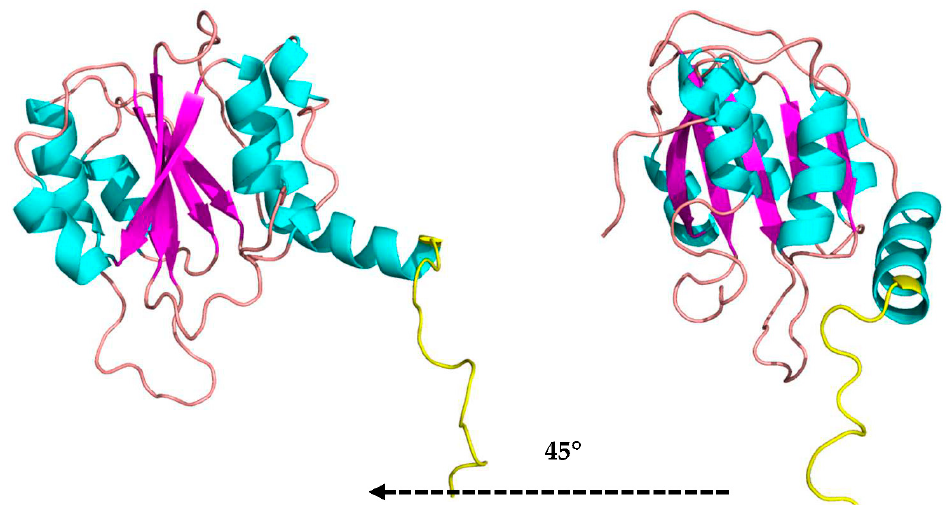
Figure 4. The C-terminal domain folded as a sandwich 3 α /6 β /3 α in two side views (cartoon structure: α -helices in cyan, β -sheets in magenta, and loops in beige) and linker loop in yellow in the MaBgl3 model.